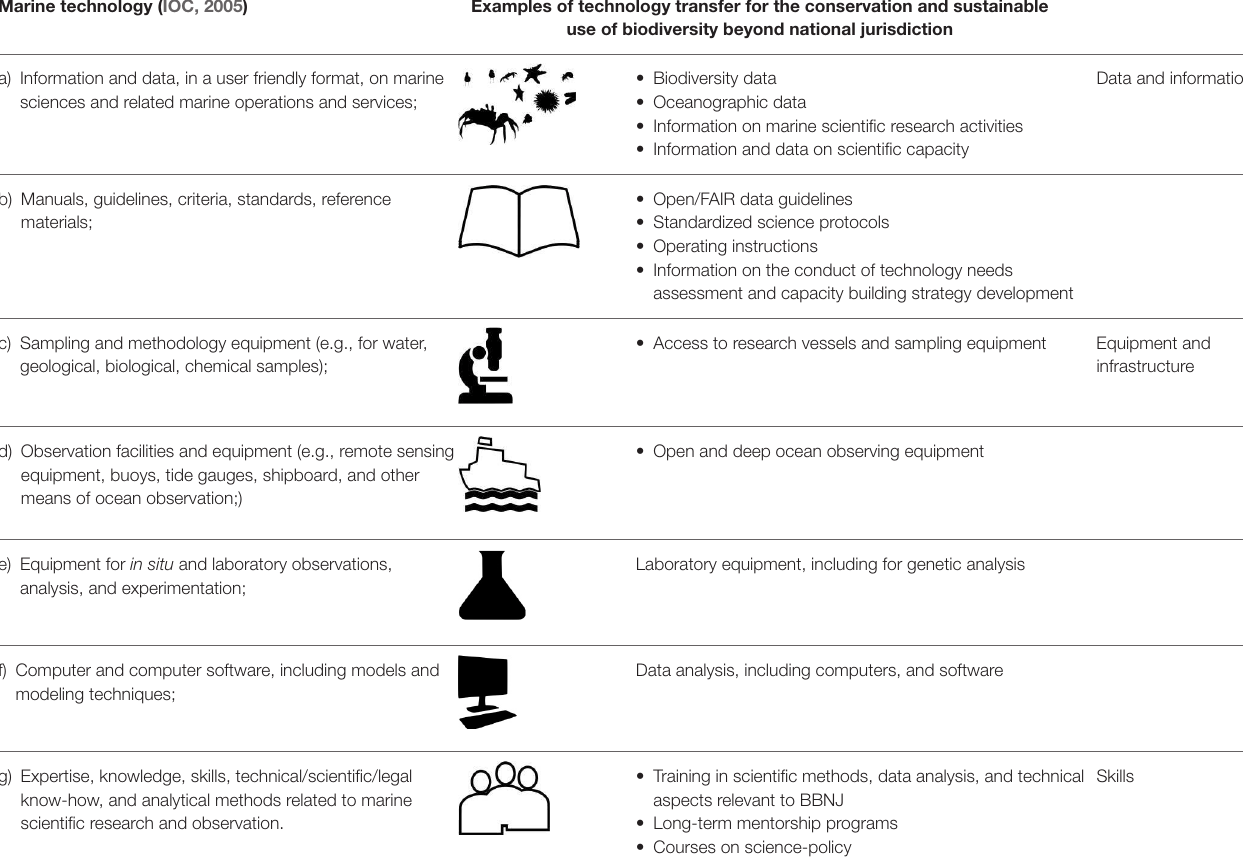
TABLE 2 | Examples of technology transfer for the conservation and sustainable use of BBNJ. Marine technology (IOC, 2005) Examples of technology transfer for the conservation and sustainable use of biodiversity beyond national jurisdiction a) Information and data, in a user friendly format, on marine sciences and related marine operations and